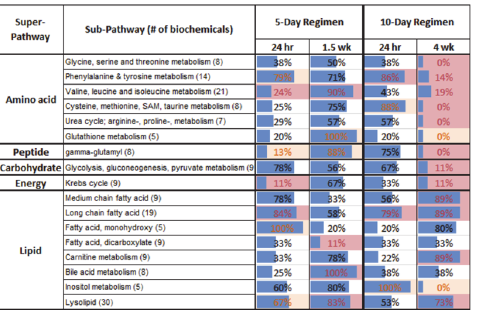
Figure 4. Percent of metabolites in subpathways elevated in AggE vs. Ctrl. Blue bars represent the percentage of all metabolites in the subpathway that were elevated in plasma of AggE vs. Ctrl mice. Red shading indicates p (cid:1) 0.05 and light orange shading indicates p (cid:1) 0.1 (exact binomial test). Subpathways were included in the figure only if there was a significant difference at these p -values in one of the four AggE vs. Ctrl